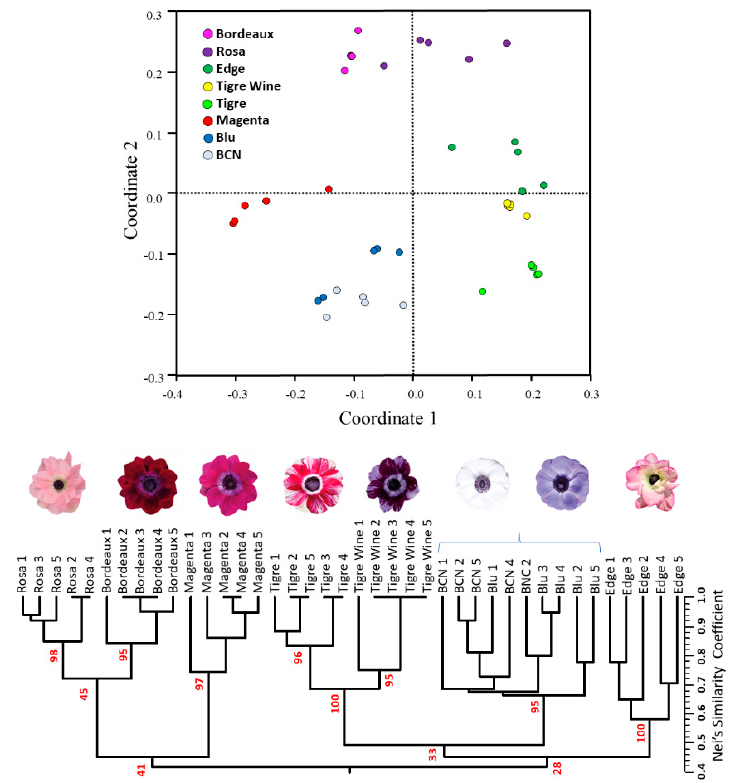
Figure 8. Dendrogram and PCoA obtained from UPGMA cluster analysis of five plants for each of the eight cultivars, based on six microsatellites (47 alleles). Bootstrap values (%) for the main nodes are reported in red.